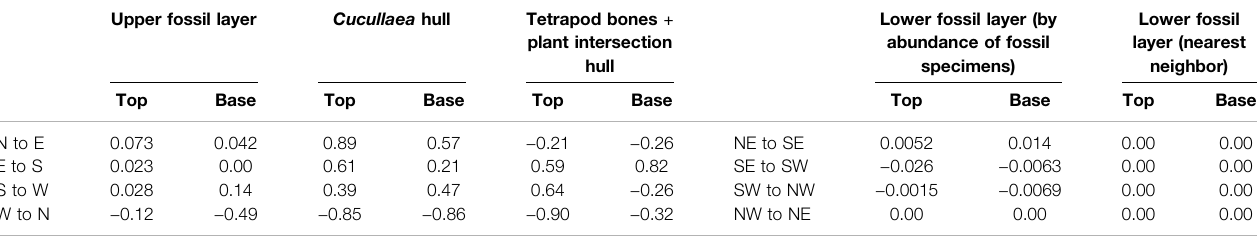
TABLE 3 | Comparison of calculated slope values for the top and base of both fossil layers identi fi ed herein within the lower Hornerstown Formation. The Cucullaea hull slopes are values from the specimens one standard deviation below and two above the mean height. The upper fossil layer slopes pertain to a combination of the Cucullaea hull specimens with those forming the tetrapod bones + plant intersection hull. The last set of slopes was calculated from the most concentrated region of specimens found by the nearest neighbor analysis. All directions are abbreviated.